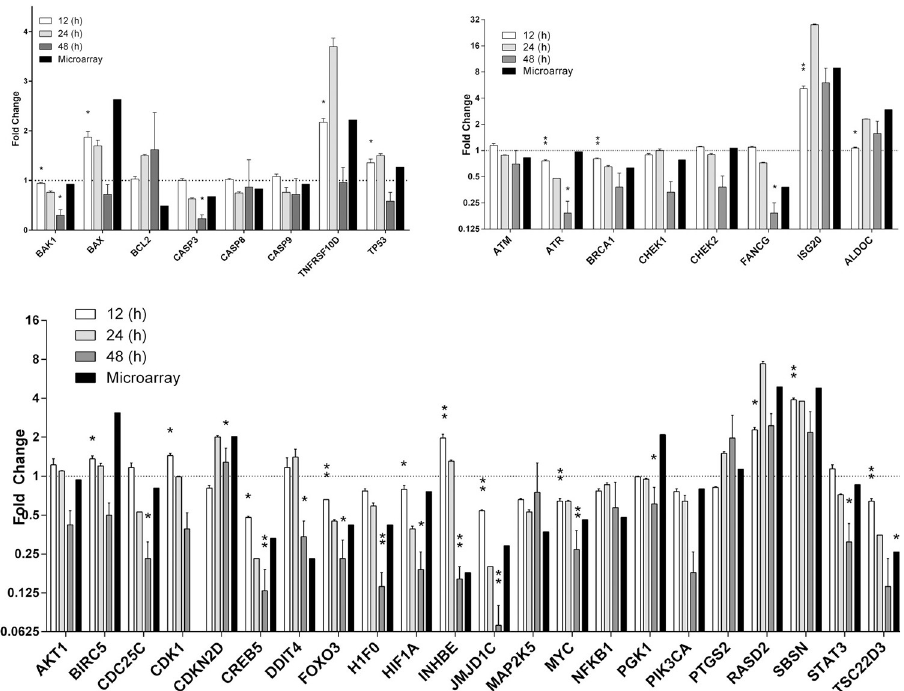
Fig 8. HPV16 E1 impacts host gene expression. Quantitative real-time RT PCR was performed on pEGFP and pEGFP-E1 transfected cells. Fold change between pEGFP and pEGFP-E1 is displayed. A: Apoptosis regulating genes. B: DNA Damage, immune response and metabolism regulating genes C: Cell proliferation regulating genes ( p - value < 0.05 denoted by � and < 0.01 by �� ).